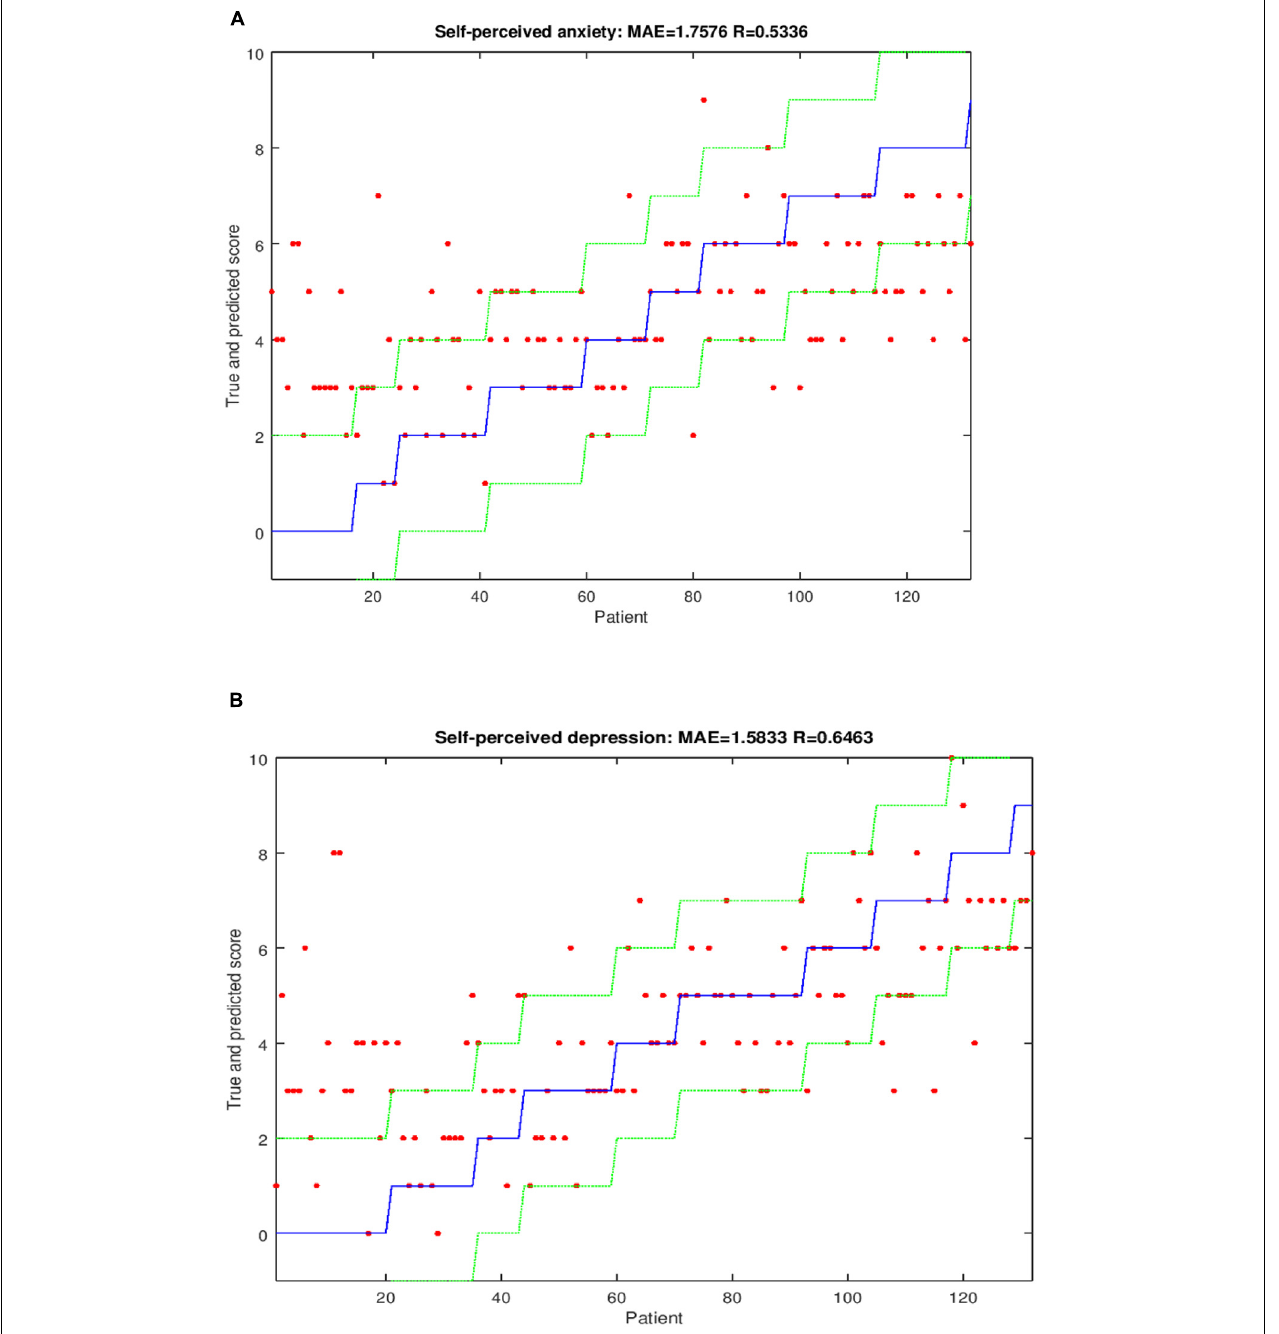
FIGURE 1 | (A) Graphical representation of Y-BOCS during the pandemic without inclusion of gender and using the regressor SVR. (B) Percentage of patients correctly classified within different tolerances for Y-BOCS during pandemic using the SVR